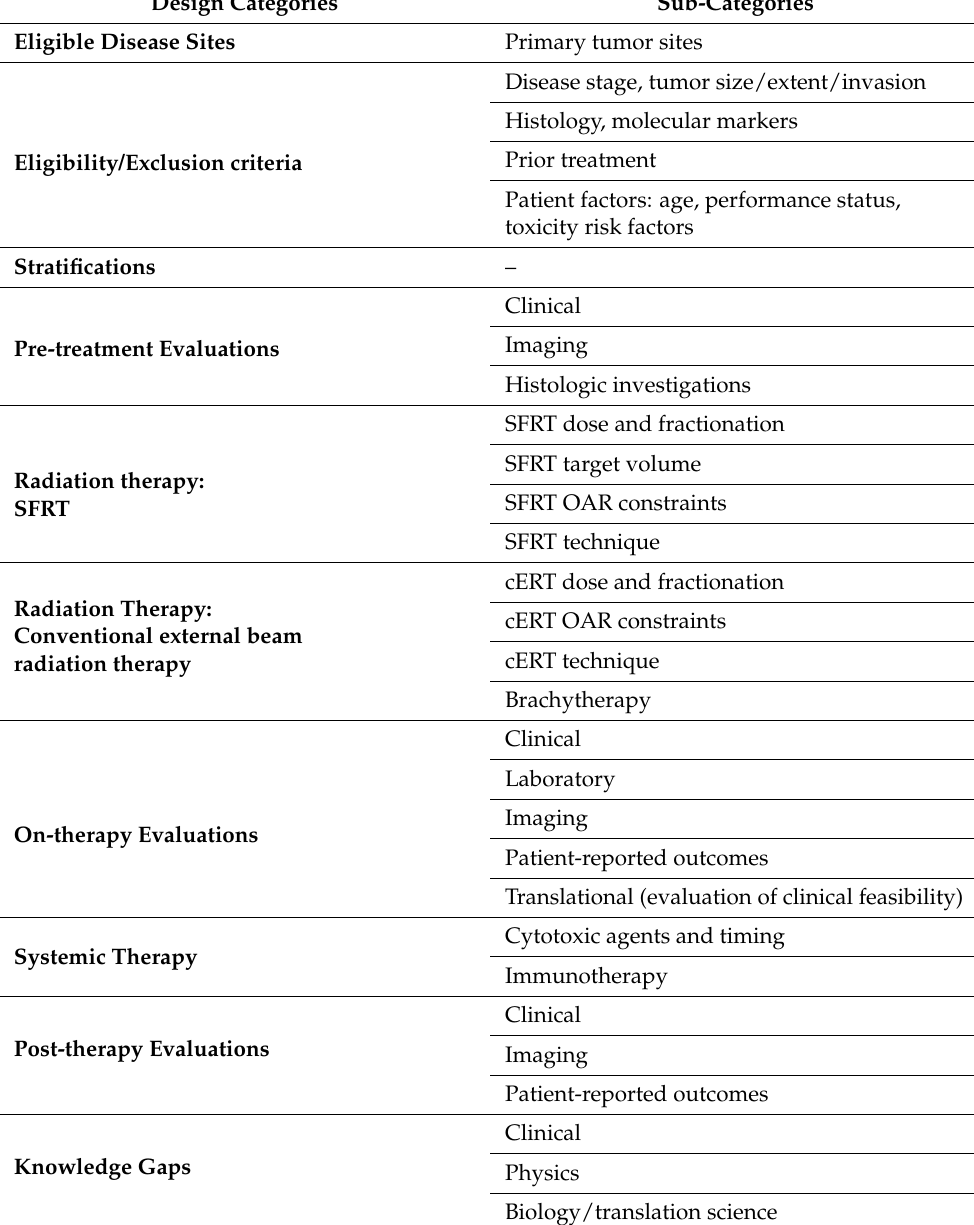
Table 2. Clinical trial design